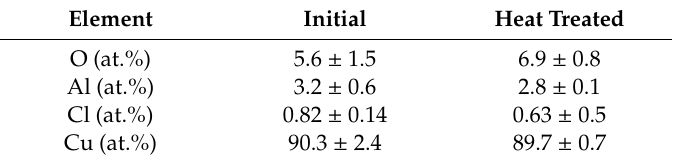
Figure 2. X-ray di ff raction (XRD) patterns of ( a ) the initial as-processed Cu nanofoam and ( b ) the same sample annealed at 400 ◦ C for 6 h. Table 1. Chemical composition of the Cu nanofoam in the initial state and after heat